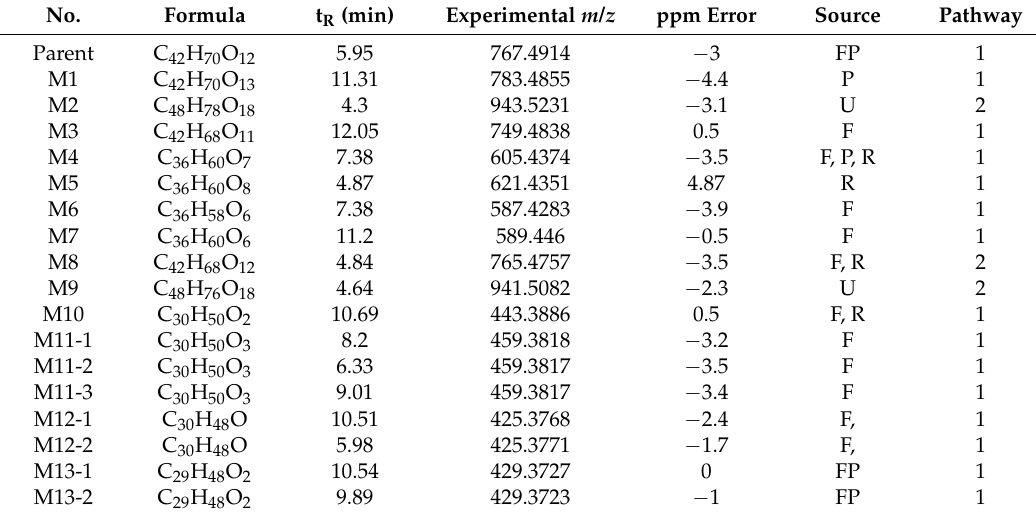
Table 1. Retention time (t R ) and fragment ions of the metabolites of Rg5 in rat by UPLC/TOF-MS